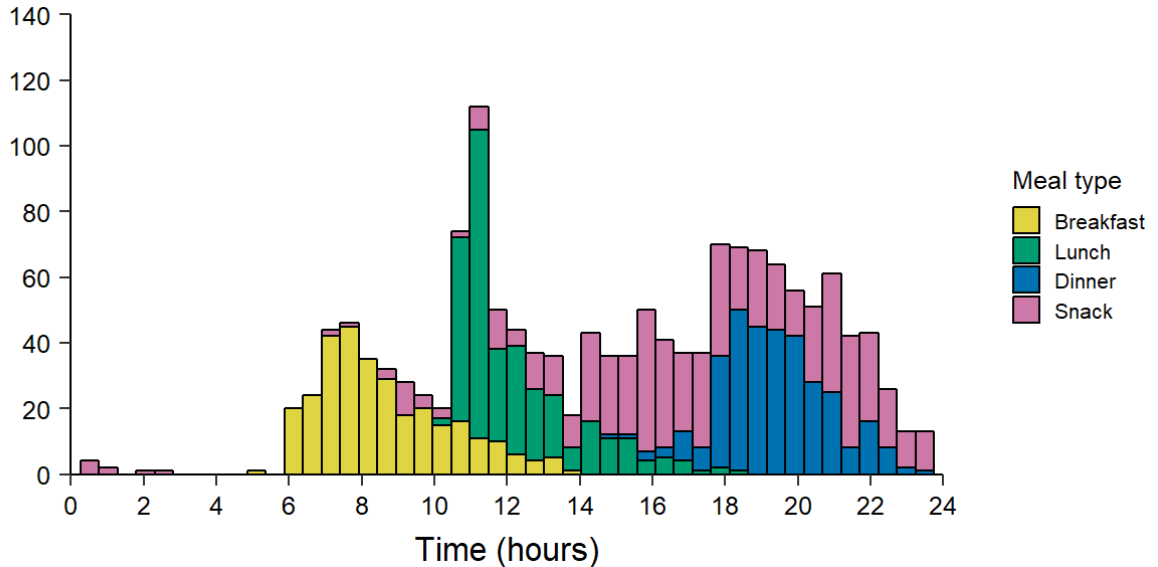
Figure 4. Histogram depicting the meal distribution of breakfast, lunch, dinner, and snacks across the day for all registered meals. Registration was done by 24 participants for a period of 2-3 weeks.